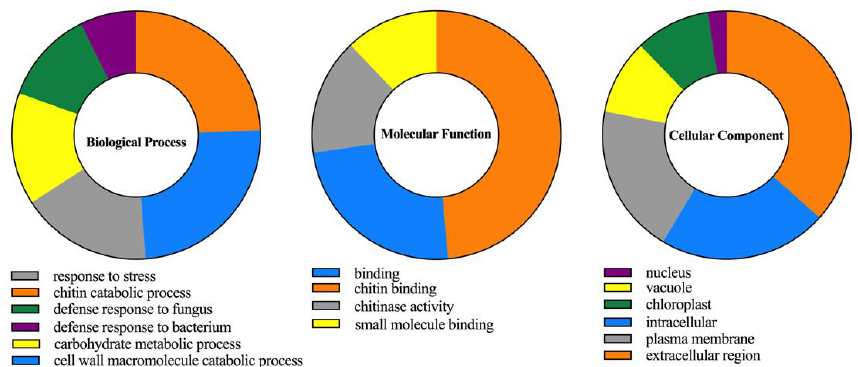
Figure 6. Gene ontology analysis of CaChi proteins in three categories (Biological processes, molecular functions and cellular component) using Blast2Go program. Different colors which are indicated near the graphics show different biological process, molecular functions and cellular component of pepper chitin-binding protein family genes.